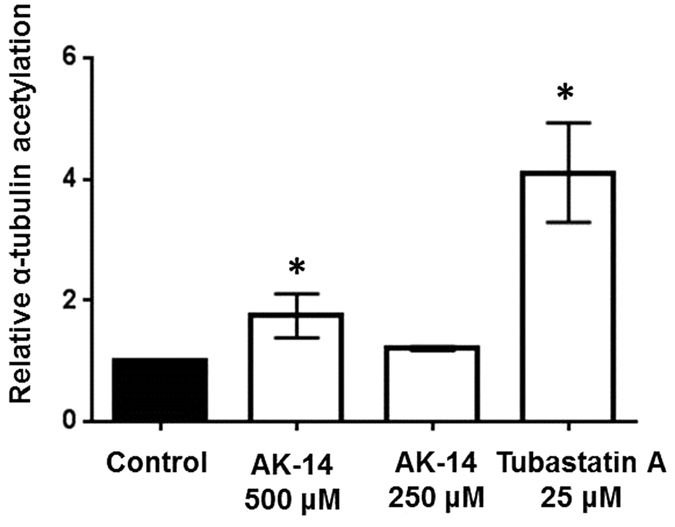
Relative α-tubulin acetylation in HeLa cells treated with AK-14 and Tubastatin A (*P < 0.05, two-sided t-test).Results are presented as the mean of 3 independent experiments in triplicate with error bars representing the standard deviation (SD).